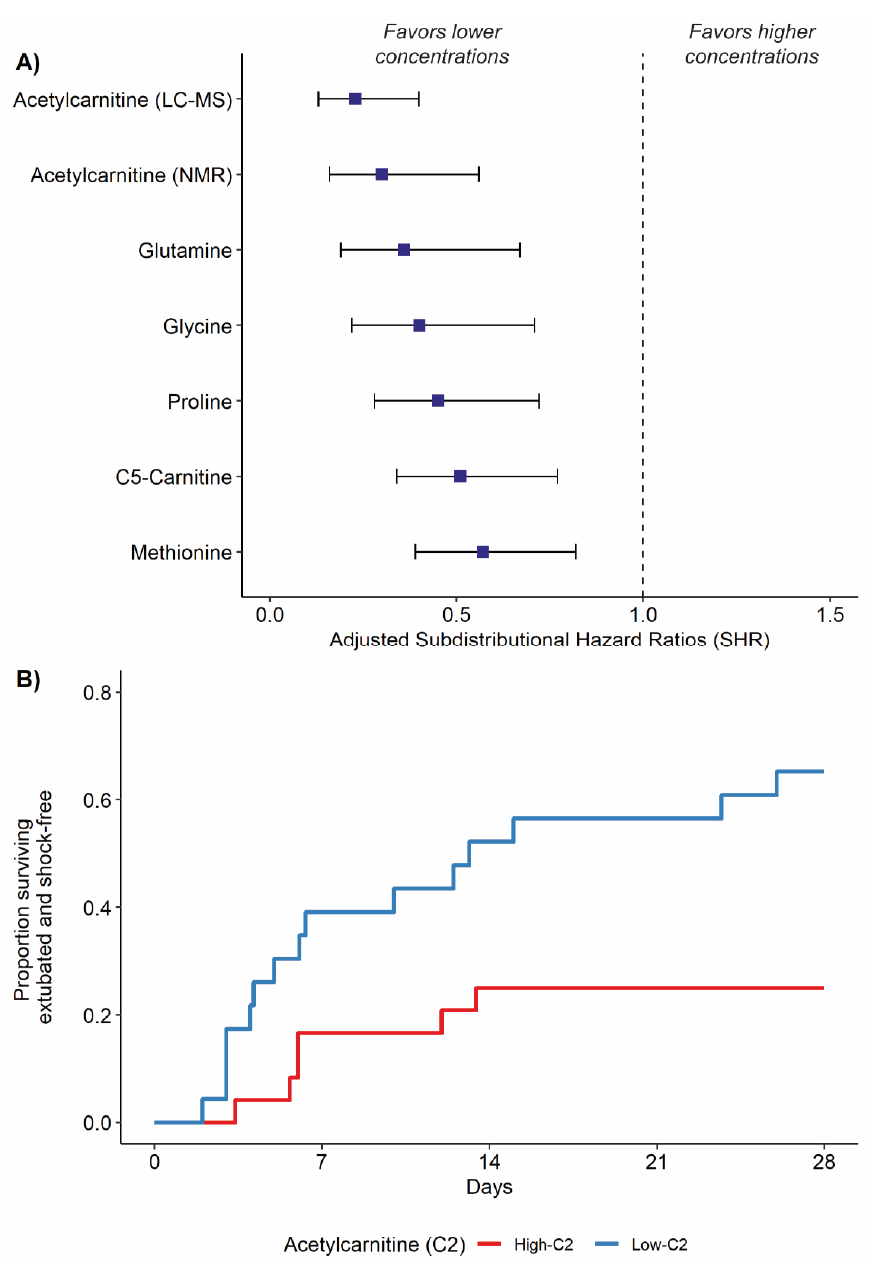
Figure 3. Comparison of time to successful extubation and freedom from vasopressors based on baseline serum metabolite levels. ( A ) The adjusted sub-distributional hazard ratio (SHR) for top metabolic features (FDR < 0.05) related to time to extubation and freedom from vasopressors. The SHR was determined using a competing risk survival model for time to extubation, with death in the first 28 days as a competing risk. Each model was adjusted for baseline SOFA score, sex, and the Charlson comorbidity index. For all metabolites displayed above, lower concentrations were asso- ciated with a greater incidence of successful extubation and freedom from vasopressors. ( B ) Visual- ization of time to breathing unassisted upon dichotomizing the top metabolic feature, acetyl- carnitine (C2), above and below the median value. There was a higher proportion of patients with low C2 that survived, were extubated and shock-free over time versus patients with high C2.